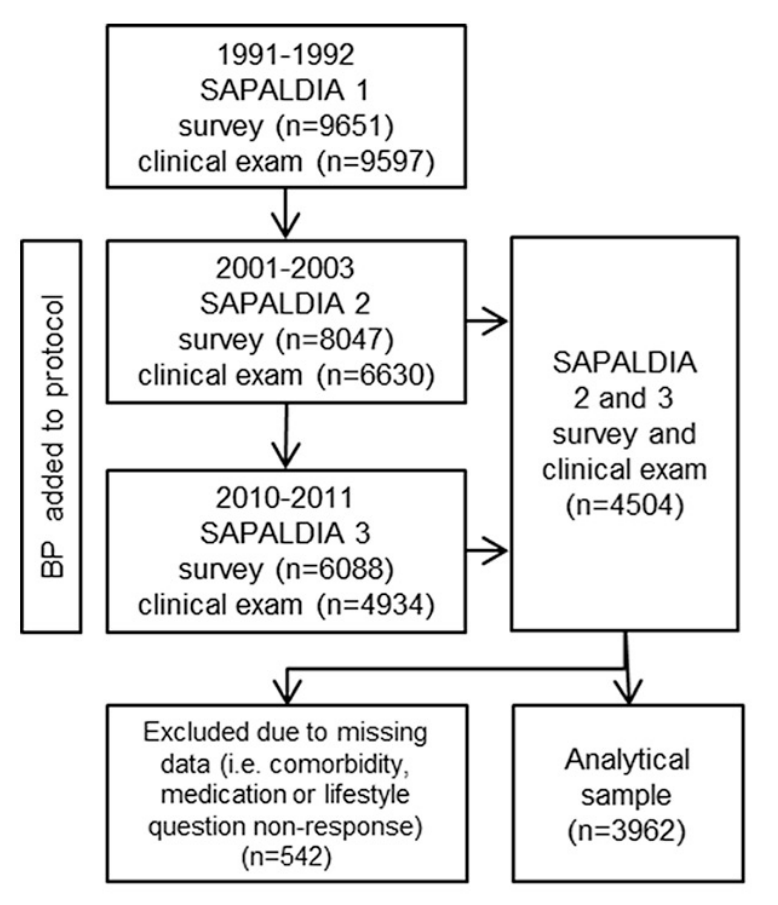
Selection of study